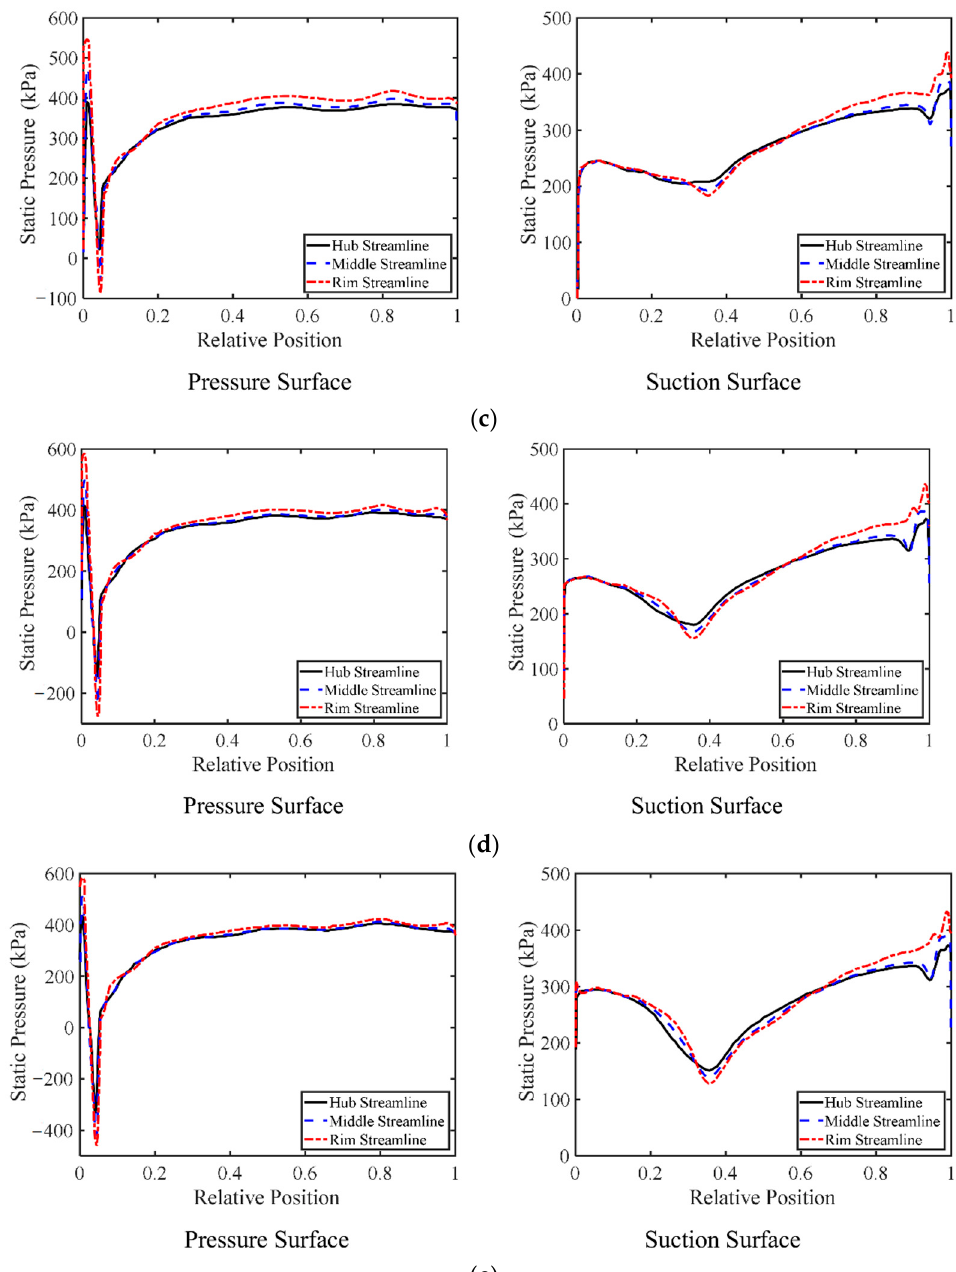
Figure 8. Static pressure distribution curves of helicon-axial pump with different flow rates. ( a ) Q